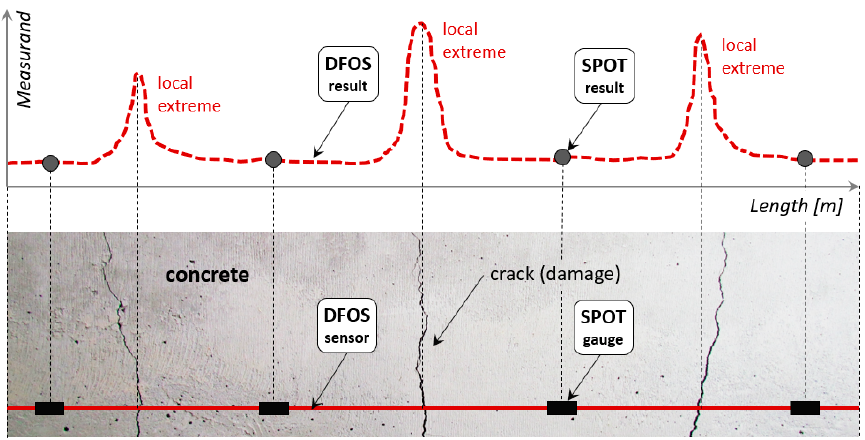
Figure 1. Graphical comparison between the capabilities of DFOS sensors and spot gauges.